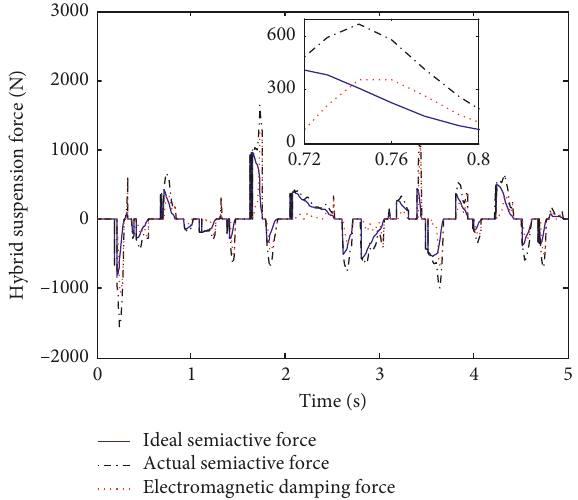
Figure 14: Damping comparison of the hybrid suspension in semiactive